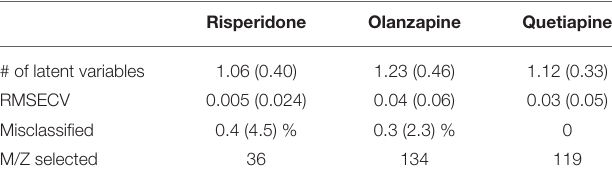
TABLE 2 | Performance of double cross-validated PLS-DA models after N = 500 random iteration (average values and standard deviations in the brackets) to select the main m/z signals while classifying between responders and non-responders for each treatment